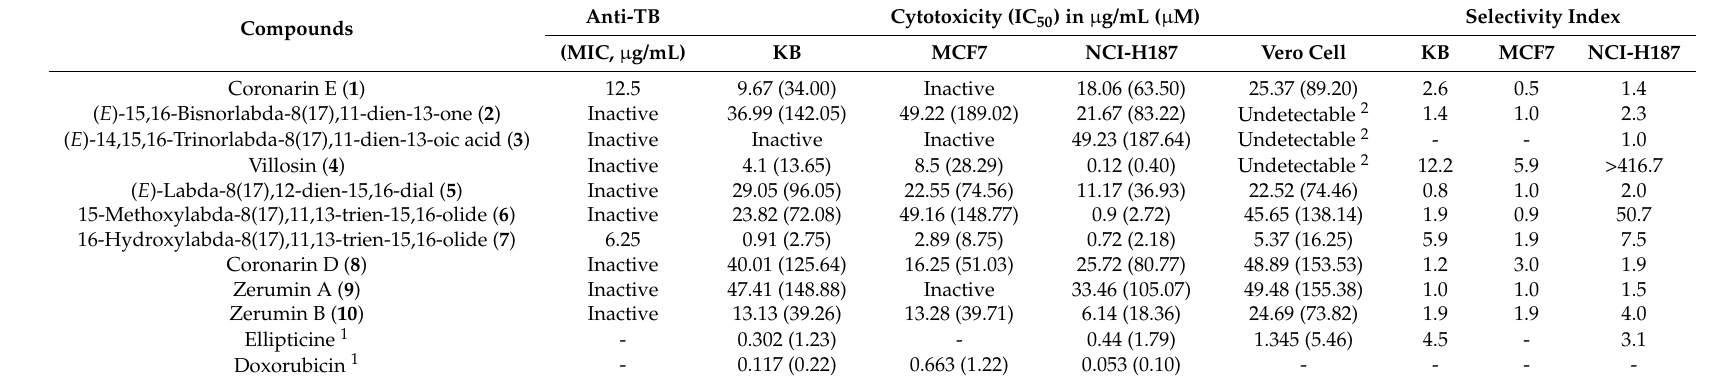
Table 1. Anti- Mycobacterium tuberculosis H37Ra (Anti-TB) and cytotoxic activities of isolated compounds.